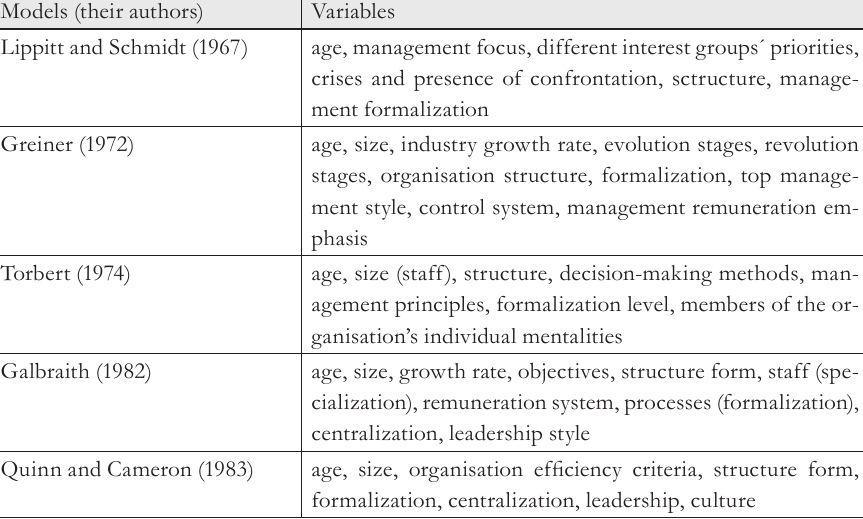
Tab. 1 – Models of corporate life cycle and variables to identify the partial phases. Source: Shi- rokova (2009). Models (their